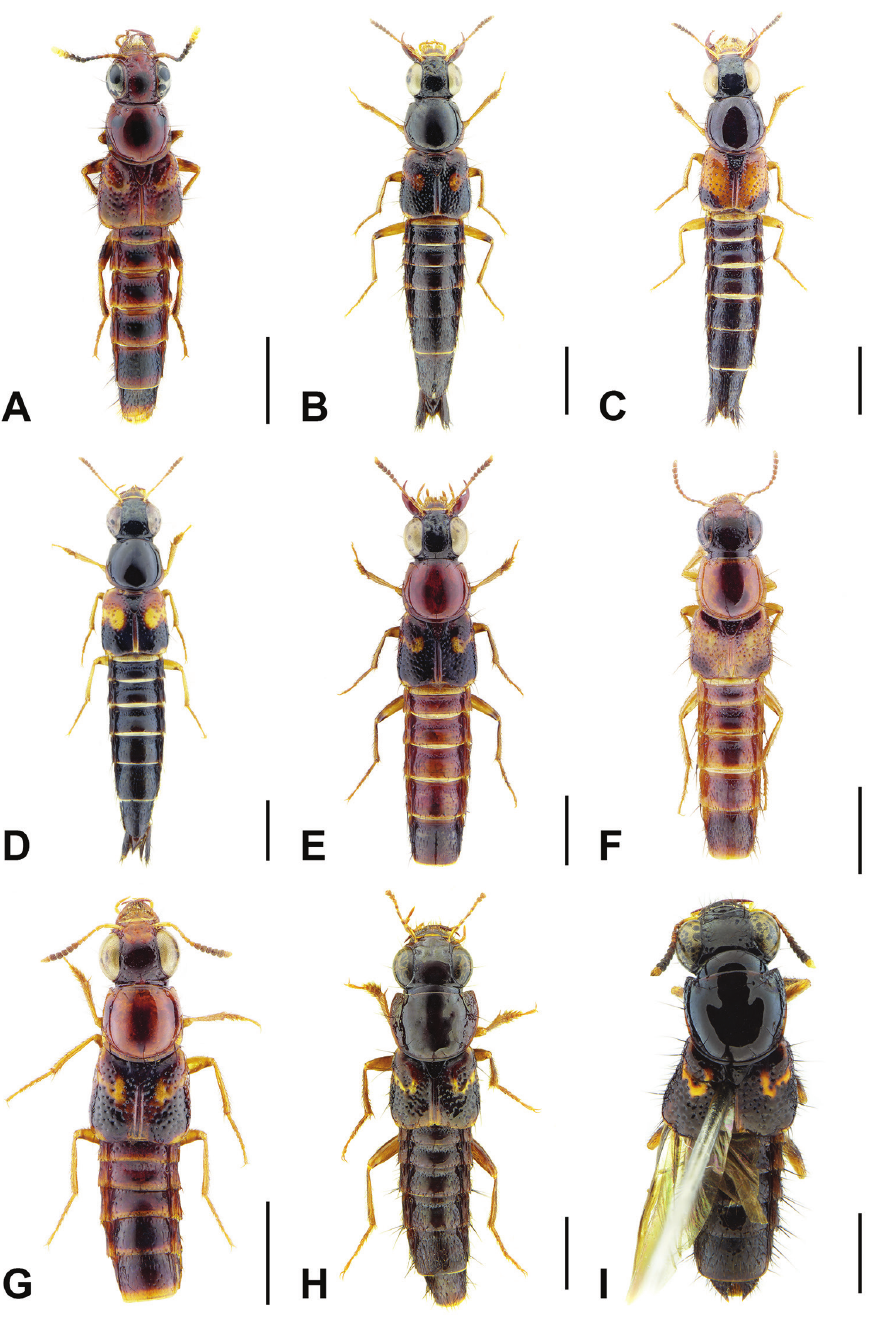
Figure 2. Dorsal habitus of Bolitogyrus sepilok Brunke ( A ), B. schillhammeri Brunke ( B ), B. flavus Yuan et al. ( C ), B. fukiensis (Scheerpeltz) ( D ), B. solodovnikovi Brunke ( E ), B. smetanai Brunke ( F ), B. elegans (Cameron) ( G ), male B. signatus (Cameron) ( H ) and female B. signatus ( I ). Scale bars: 2